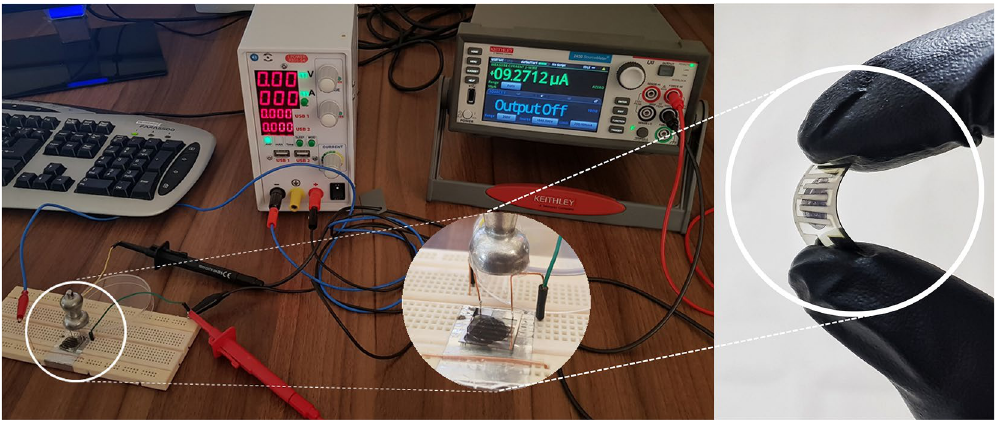
Figure 10. Photograph of electrical measurement set-up and the magnified photograph of the fabricated flexible biosensor.